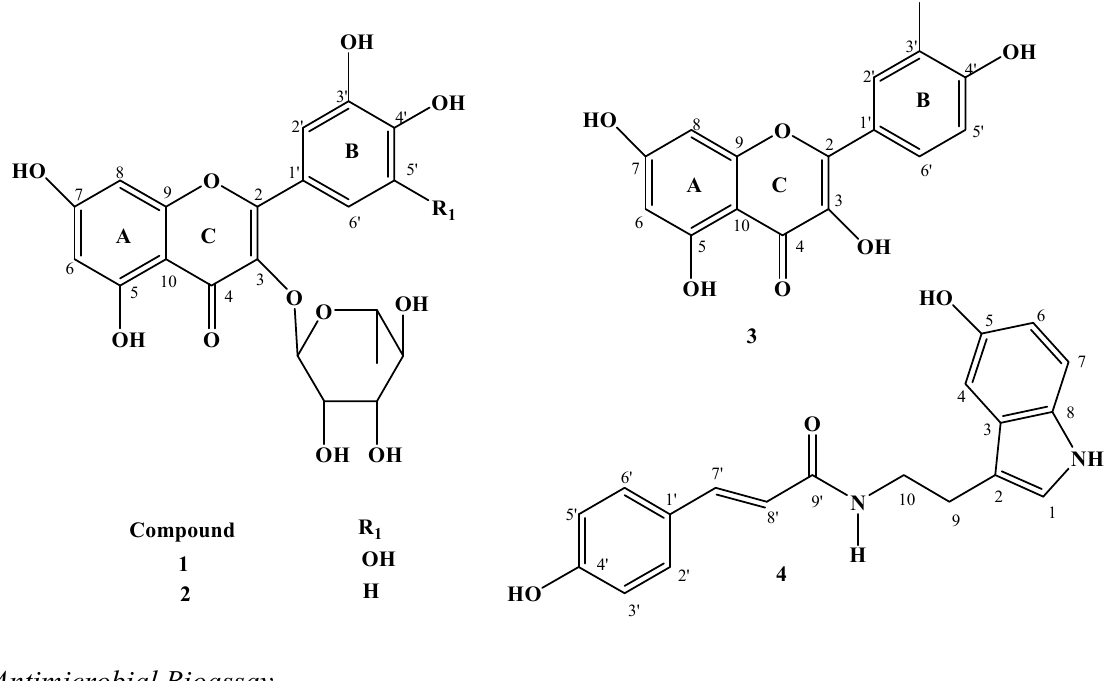
Figure 1. Structures of isolated compounds from C. menyharthii leaf